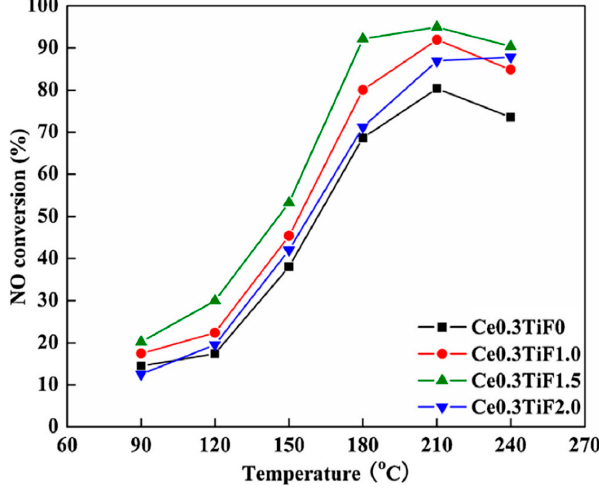
Figure 23. NO x conversion of Ce 0.3 TiF y catalyst with different F doping Reaction conditions: 100 mL/min, 0.05% NO, 0.06% NH 3 , 5 vol% O 2 , N 2 balance, GHSV = 28,000 h − 1 [94].